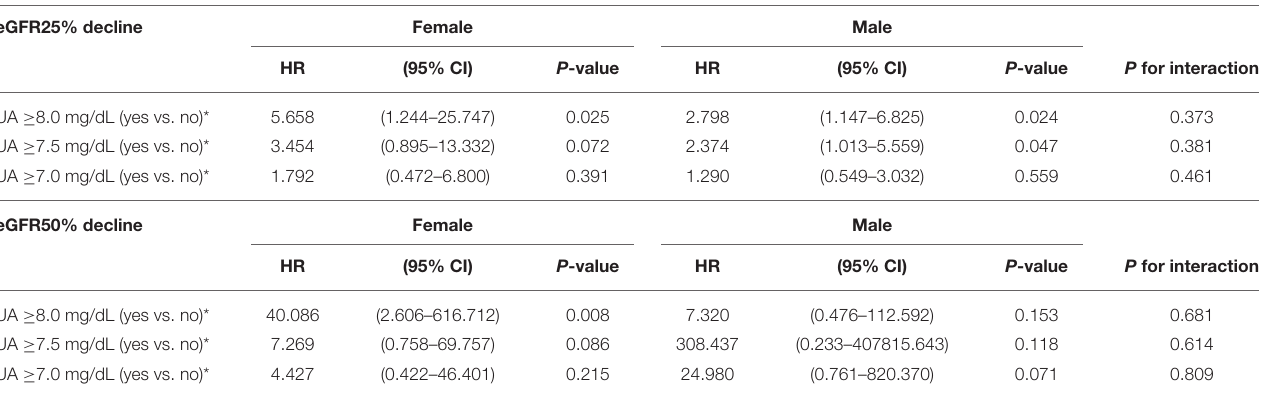
TABLE 9 | Uric acid levels and decline of estimated glomerular filtration rate (eGFR) in female and male. eGFR25%